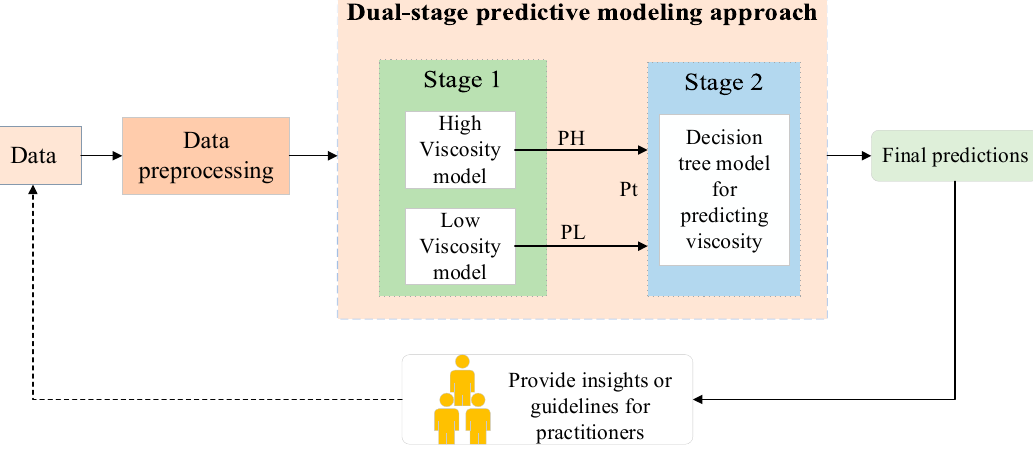
Figure 1. The proposed dual-stage predictive modeling approach for predicting slag’s viscosity.